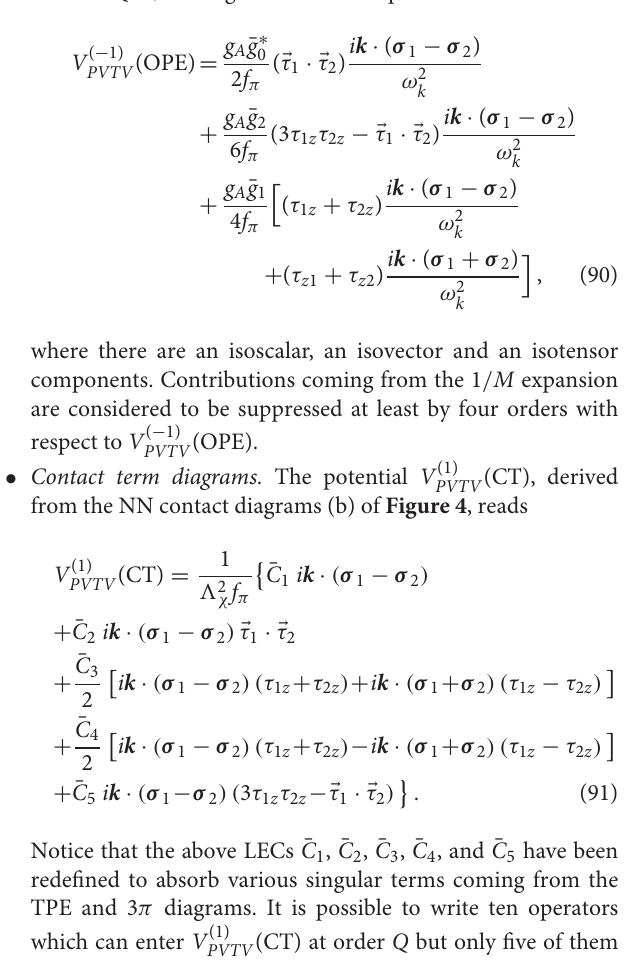
of order Q − 1 , coming from the NR expansion of the